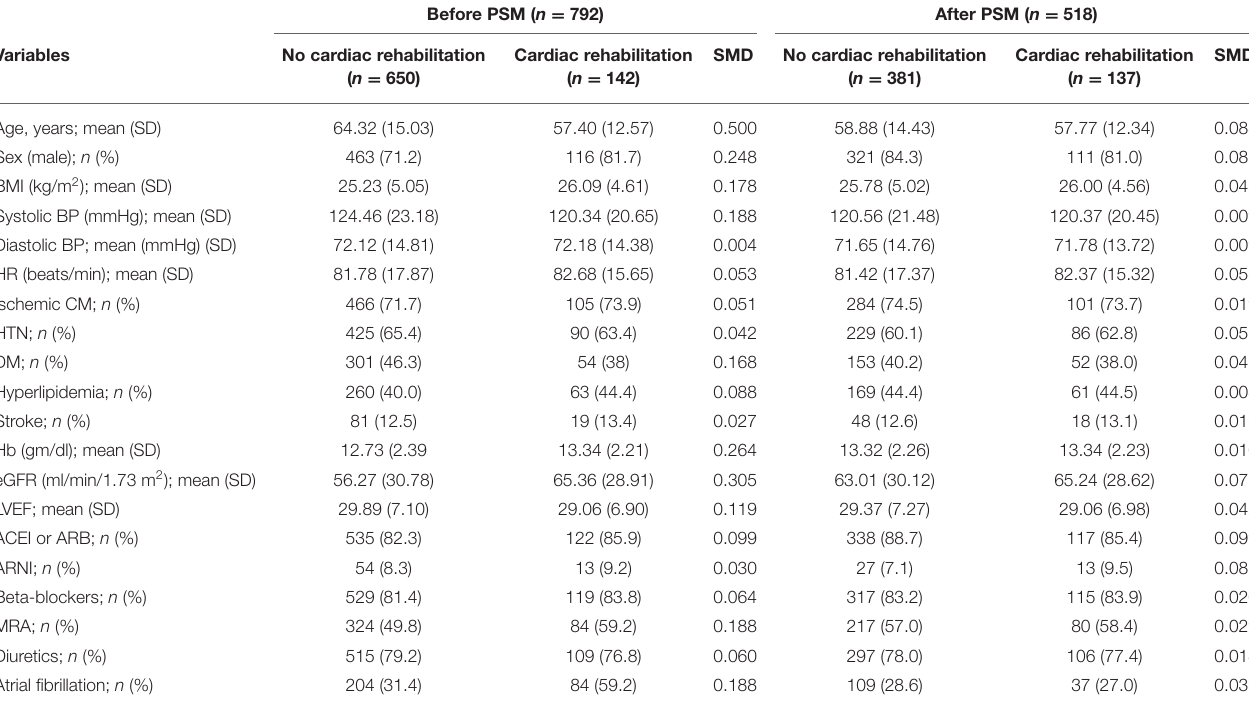
TABLE 1 | Patient characteristics before and after matching.